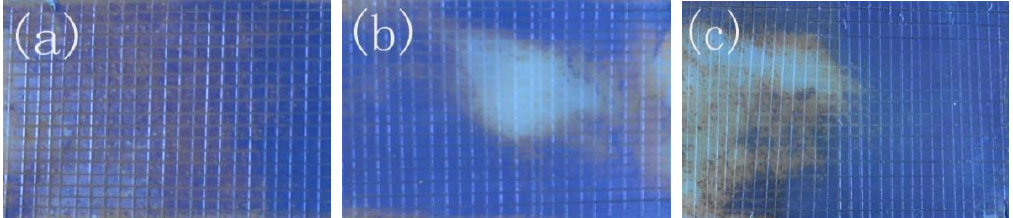
Figure 5. Adhesion property of copper film after saline solution immersion. ( a ) TES-SAMs modified; ( b ) MPTMS-SAMs modified; ( c ) APTES-SAMs